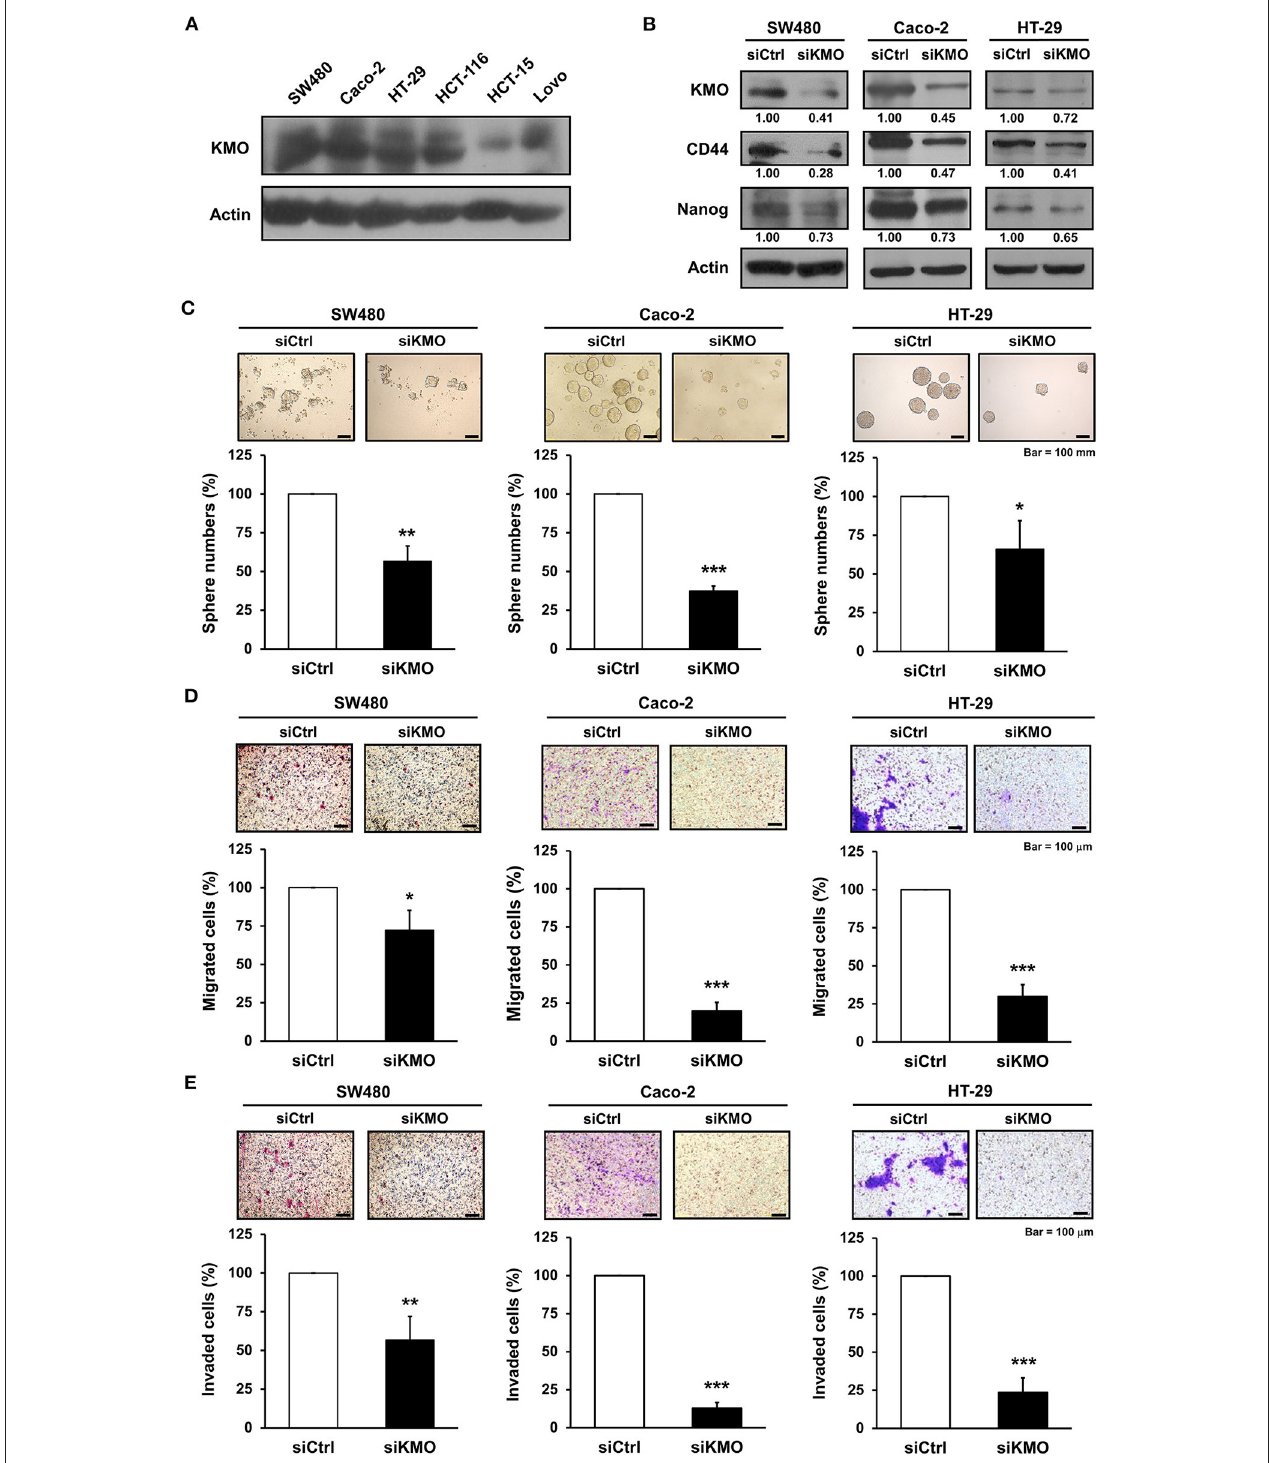
FIGURE 3 | Knockdown of KMO suppresses stemness properties and motility of CRC cells. (A) Whole-cell extracts of SW480, Caco-2, HT-29, HCT-116, HCT-15, and Lovo cells were analyzed by western blot analysis using anti-KMO and anti- β -actin antibodies. (B–E) Whole-cell extracts of SW480, Caco-2, and HT-29 cells transduced with virus containing KMO siRNA (siKMO) or control (siCtrl) were harvested for western blot analysis using anti-KMO, anti-CD44, anti-Nanog, and anti- β -actin antibodies (B) , sphere (C) , transwell migration (D) , and invasion assays (E) . Means ± SD of three independent experiments performed in triplicate are shown [100 magnification times for (D,E) ]. Student’s t -test, * P < 0.05; ** P < 0.01; *** P < 0.001.